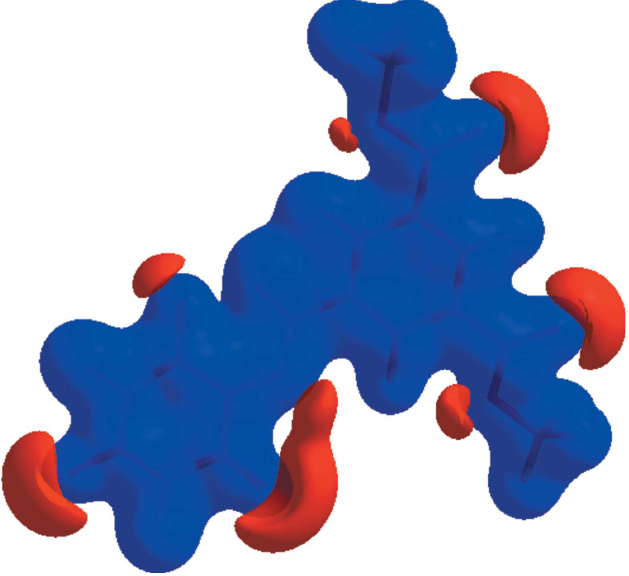
Fig. 6. The blue regions indicate positive electrostatic potential